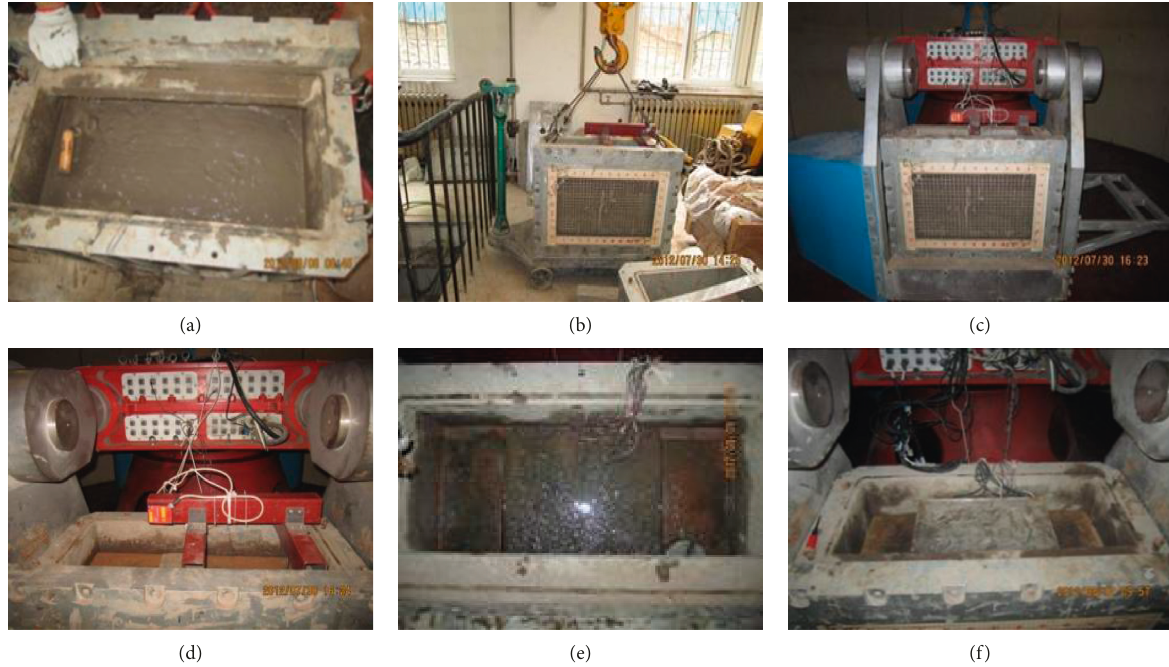
Figure 6: Test process: (a) fill in the soil sample; (b) hoisting the model box; (c) immobilization; (d) initial consolidation; (e) paving cushion; (f) placement of the immersed tunnel.